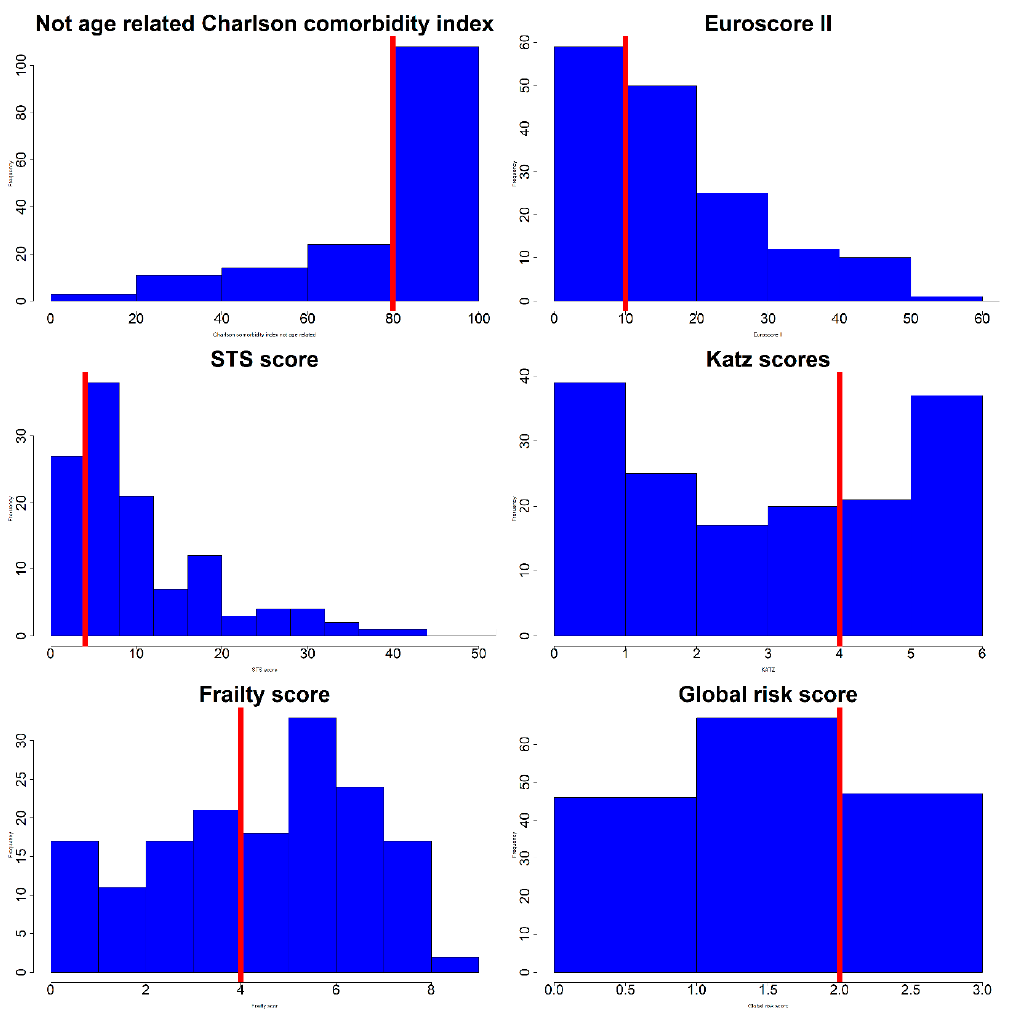
Figure A2. Risk scores of patients with IE from CVCA registry. Added vertical red line represents discrimination boundaries for elevated risk of mortality.